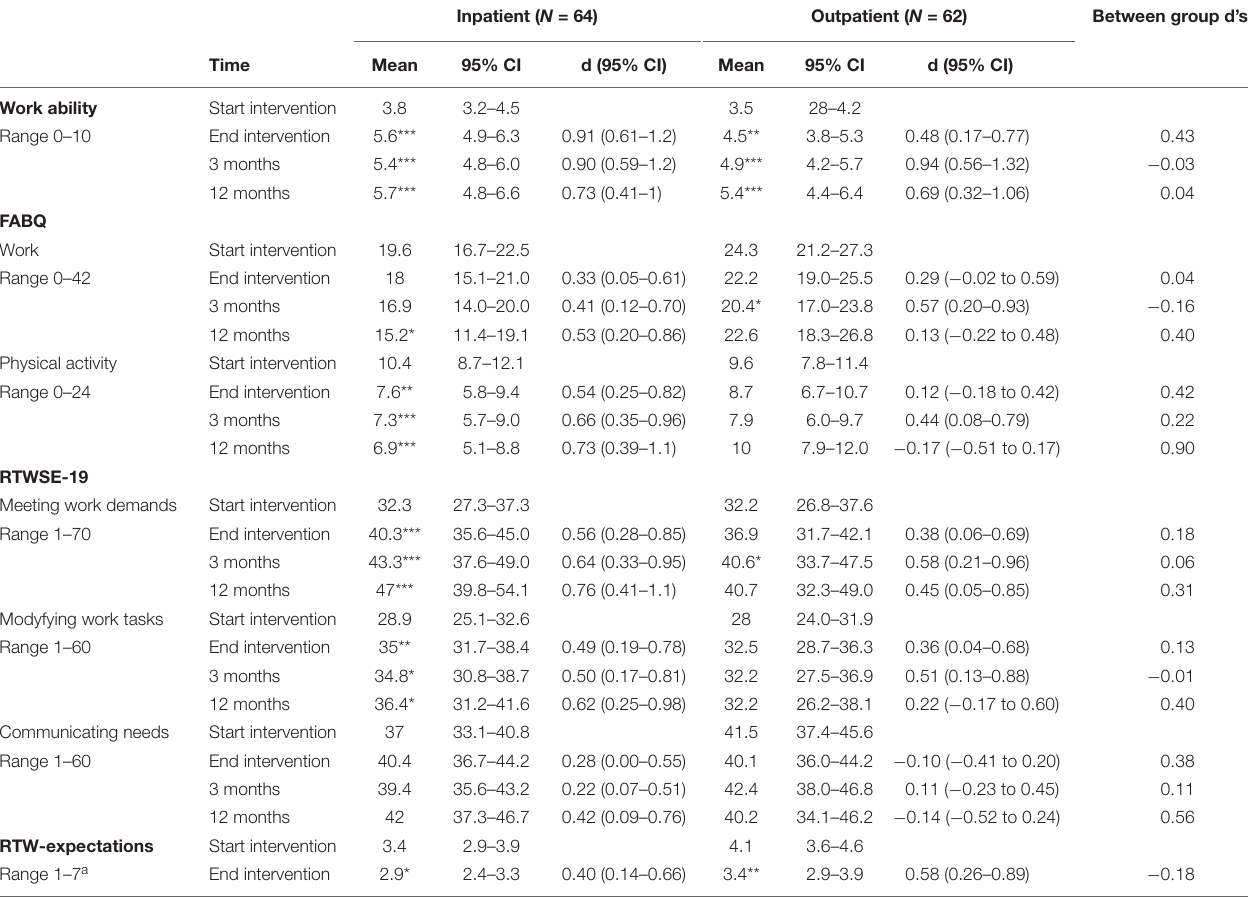
TABLE 3 | Work-related outcomes: pre- and post-test scores (M, CI), within-group effect sizes (Cohen’s d with CI), and between-group effect sizes (Cohen’s d). Inpatient ( N = 64) Outpatient ( N = 62) Between group